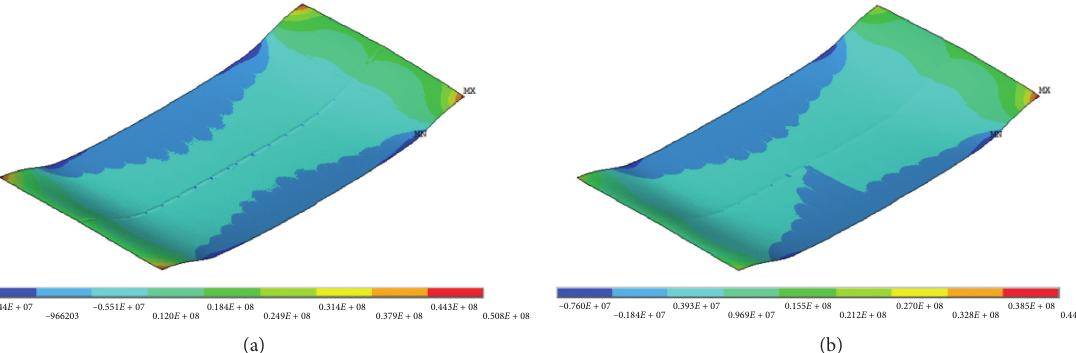
Figure 10: Nephogram of the steel-box girder roof along the bridge. (a) The steel box girder without the pavement player. (b) The steel box girder with the pavement player.